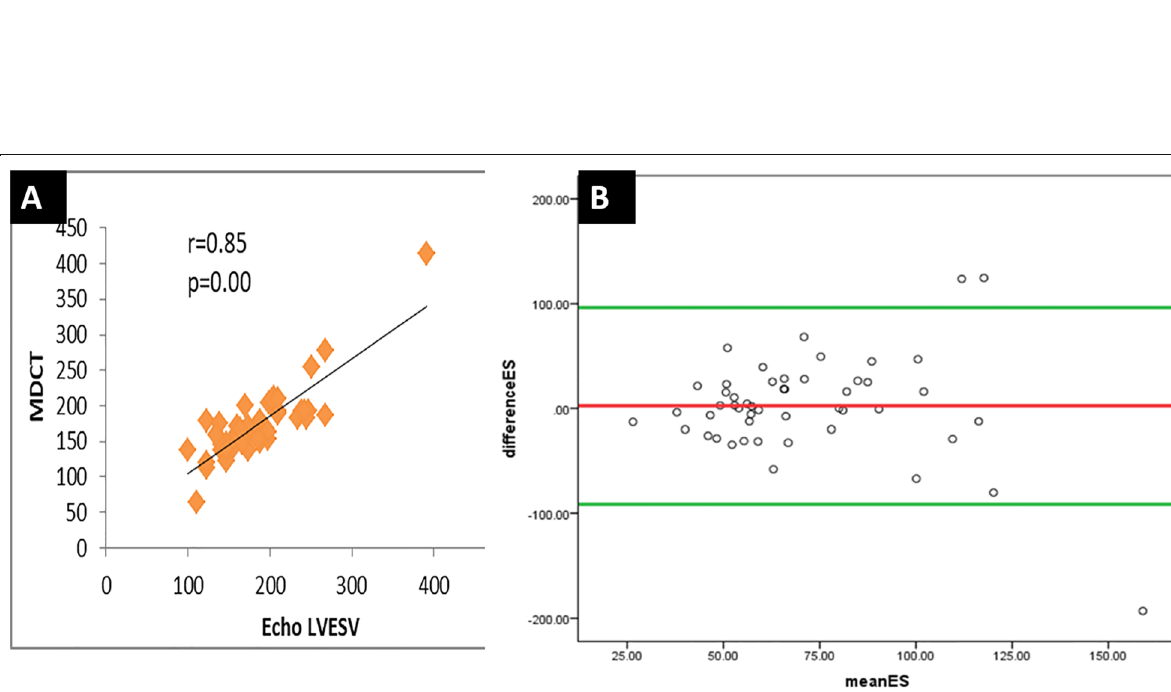
Fig. 5 a Linear regression plot correlation. b Bland-Altman plot of LVESV by MDCT and 2D echocardiography plotted against the average value of them (solid red line, mean value of difference; green line, mean value of differences ± 2